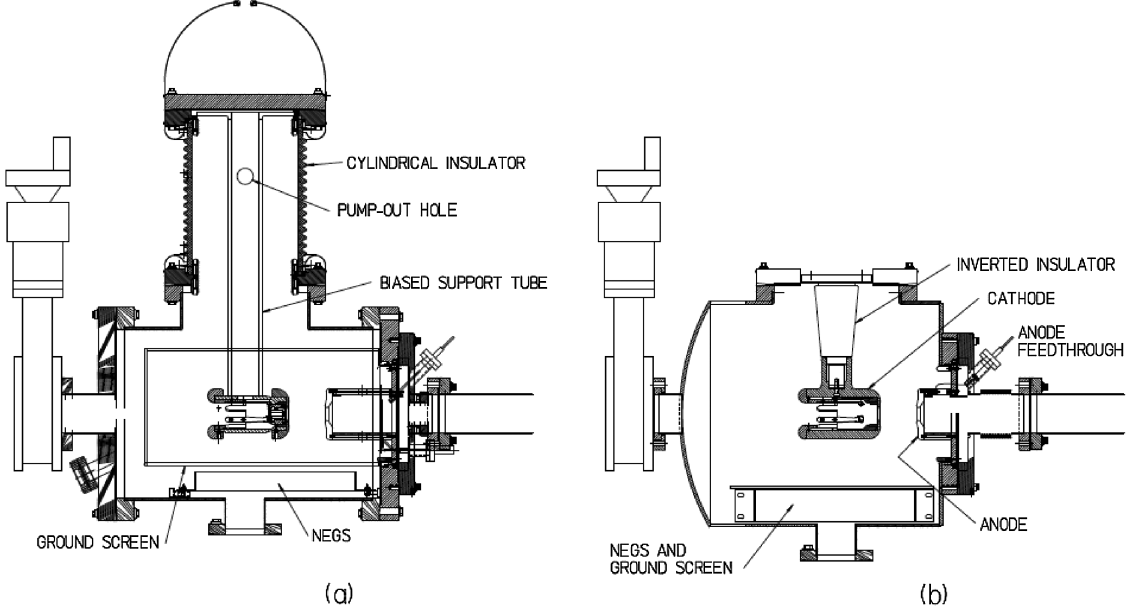
FIG. 4. Diagrams of the load-locked gun high voltage vacuum chambers: (a) conventional large-bore cylindrical insulator and (b) inverted gun with compact tapered insulator that extends into the gun vacuum vessel. Both drawings have the same scale with top flanges 10-inch diameter. The cathode-anode separation is (cid:3) 6 cm for both